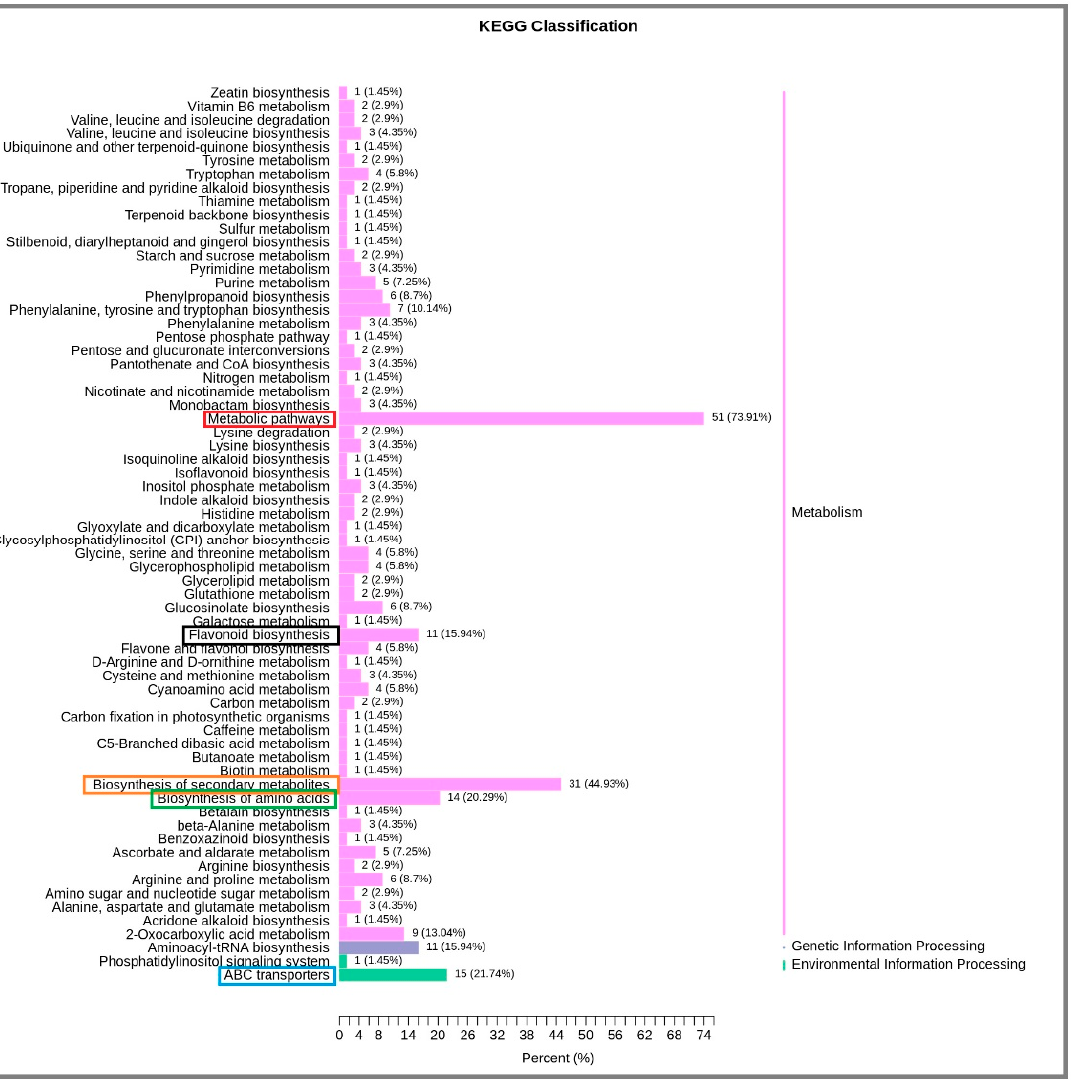
Figure 5. KEGG classification of differential metabolites of water dropwort under soil culture (CK) and Yamasaki nutrient solution (NK). Pink represents pathways related to metabolism, purple represents pathways related to genetic information processing, and green represents pathways related to environmental information processing.